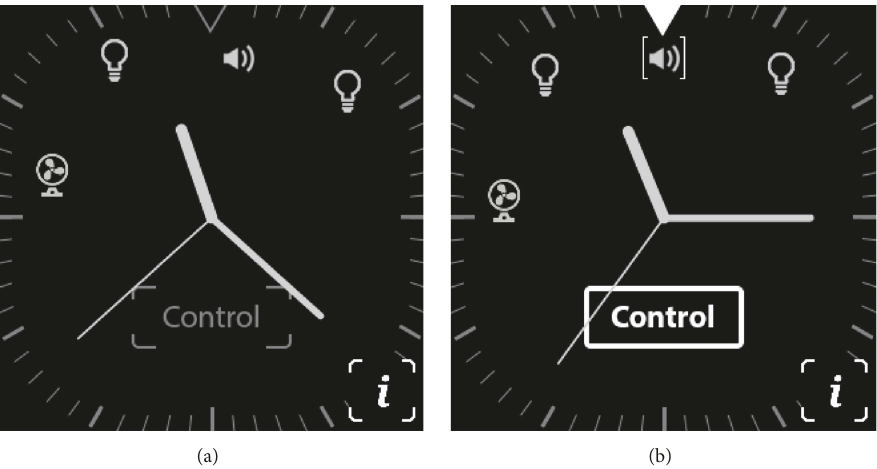
Figure 1: (a) No device in focus. (b): The Sonos sound system is in focus, indicated by a triangle and brackets.